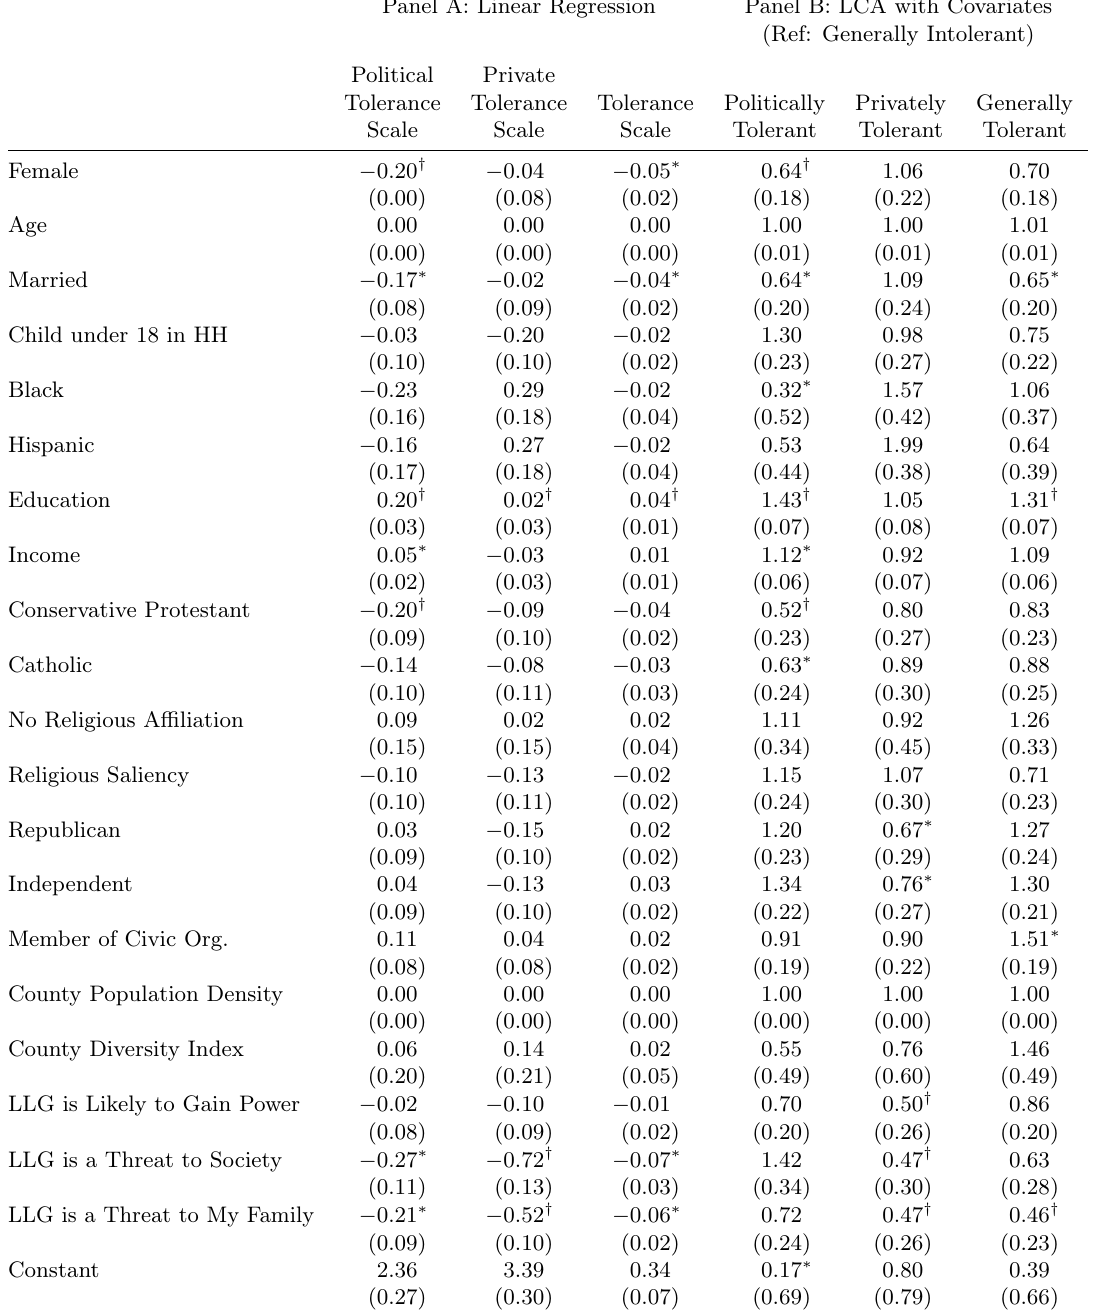
Table 7: Estimating Tolerance by Demographic, Religious, Political, and Social Context Variables Panel A: Linear Regression Panel B: LCA with